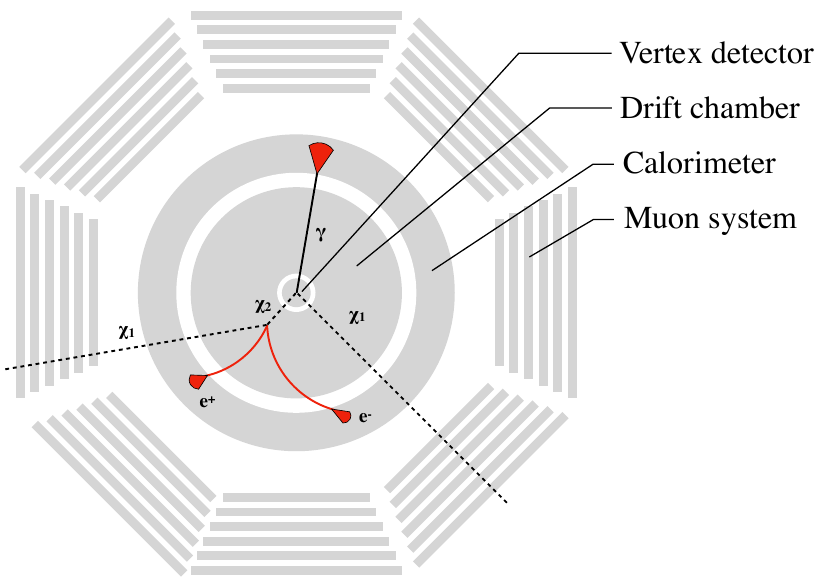
Figure 4 . Schematic view of the Belle II detector ( xy -plane) and example displaced